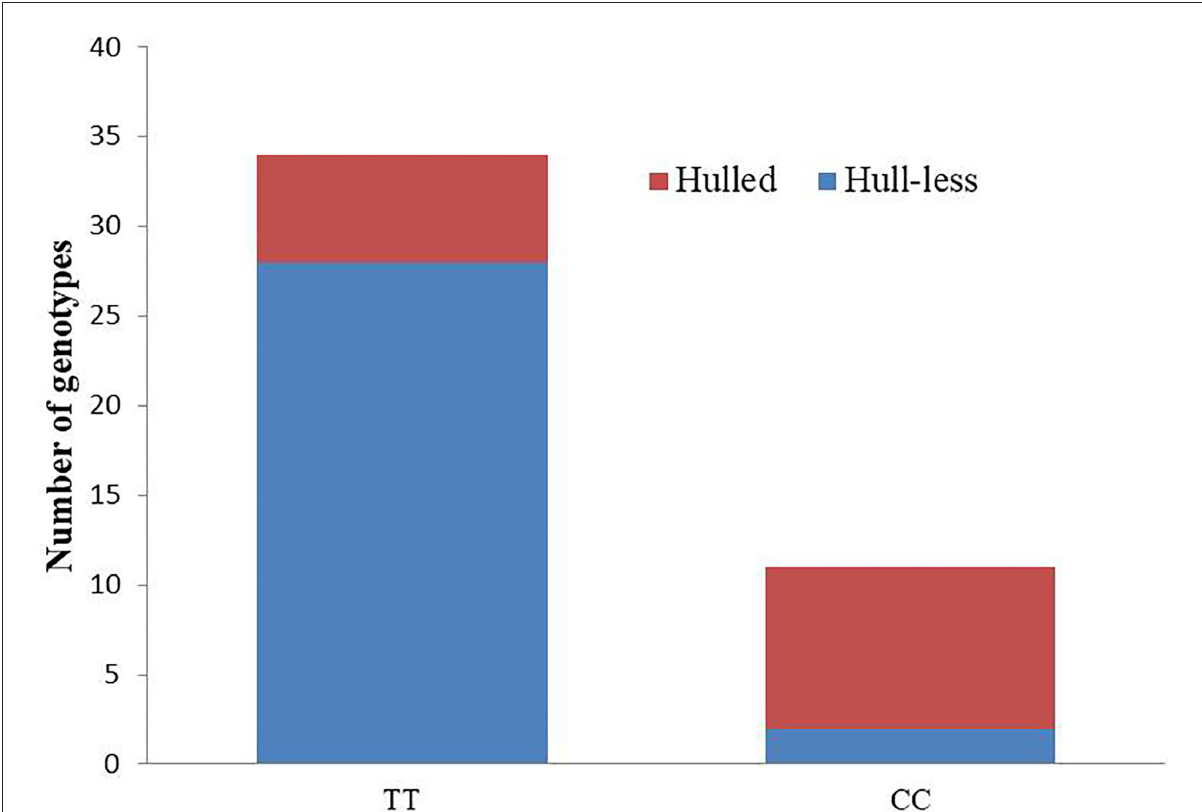
FIGURE5 Genotypic and phenotypic data for KASP assay, Cp_3430407 in the diversity panel. (Total number of genotypes = 45; hull-less: 30; hulled: 15); X -axis indicates the genotype of Cp_3430407 KASP assay (TT or CC), and Y -axis indicates a number of genotyped individuals. Red and Blue sections denote the number of individuals with hulled and hull-less seed types,